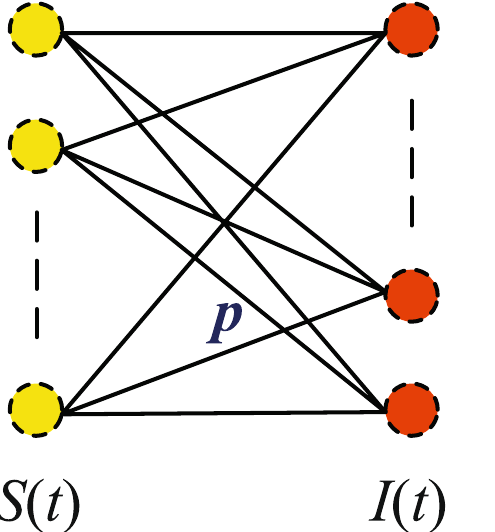
Figure 4. Number of active